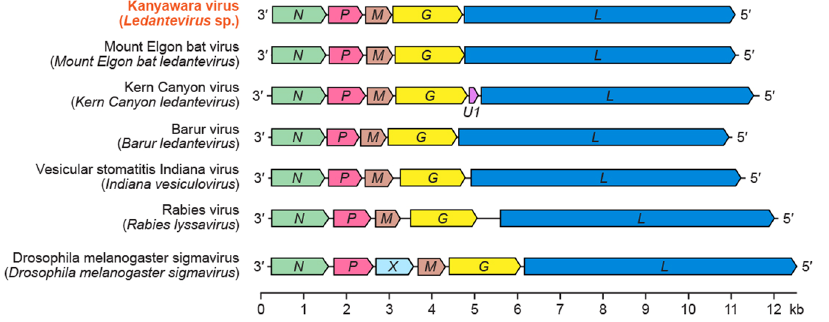
Figure 1. Comparison of the genome organization of Kanyawara virus (KYAV) to that of other members of the mononegaviral family Rhabdoviridae . Arrows signify open reading frames. Letters indicate the canonical rhabdovirus nucleoprotein ( N ), phosphoprotein ( P ), matrix ( M ), glycoprotein ( G ) and polymerase ( L ) genes and genus-specific open reading frames ( U1 , X